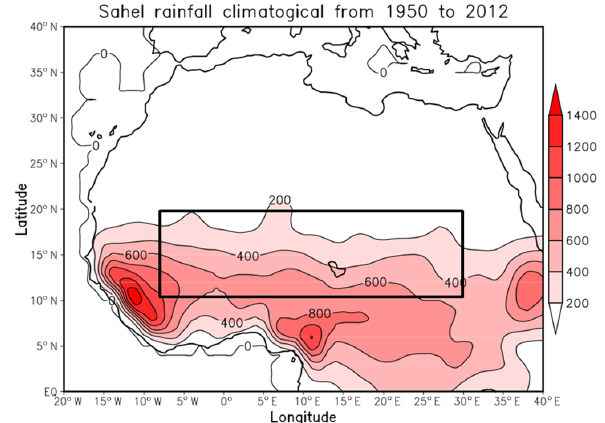
Figure 1. Climatological JAS mean of northern African regional rainfall averaged from 1950 to 2012. The area defined as the Sahel region is in the rectangle between latitude 10–20 ◦ N and longitude 8 ◦ W–30 ◦ E. The unit is mm.